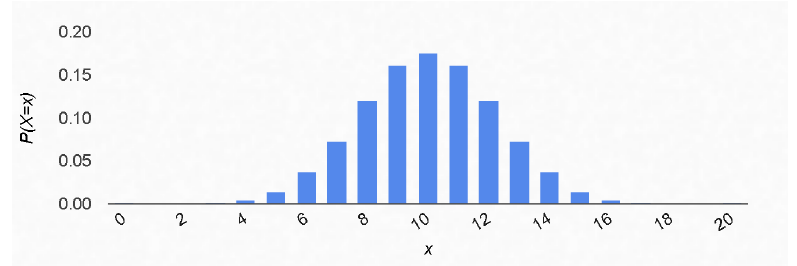
Figure 3. Tree diagram for calculating the expectation of a game that ends with two binomial trials, with a probability of success p = 3/4 and probability of failure q = 1/4. By multiplicative principles and resolving the resulting equation, the expectation or value of the situation for the player is 9/10 (adapted from [37]).